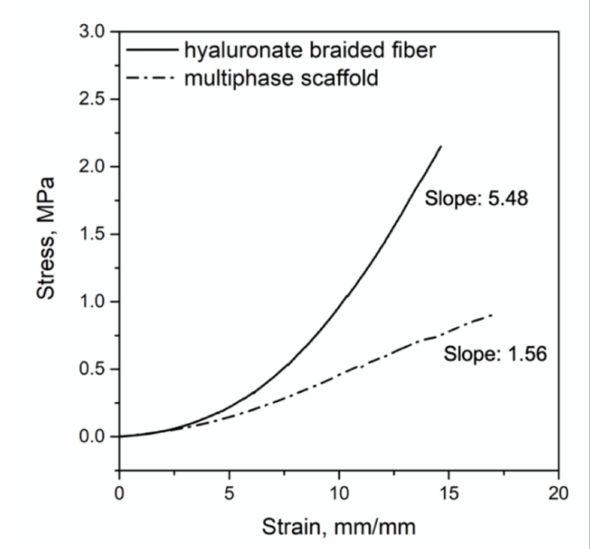
Figure 2. Mechanical characterization of the 3D scaffold. Stress–strain plot and elastic modulus values of hyaluronate braided band (continuous line) and of multiphase stem cell-based scaffold (dashed